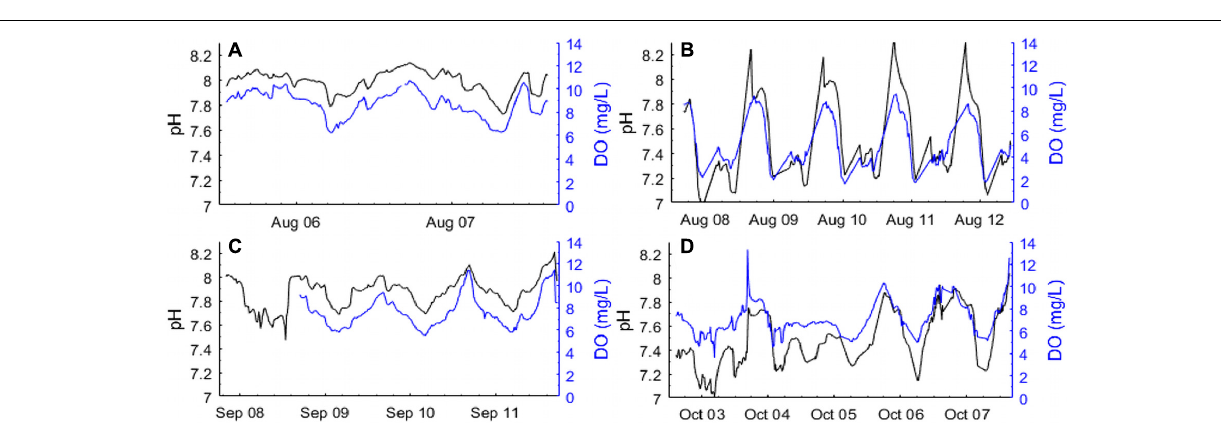
FIGURE 2 | High frequency diurnal measurements of pH T (Black lines; total H + scale) and dissolved oxygen (Blue lines; DO mg L − 1 ) in (A) a seagrass bed (SG-1) in August, (B) a salt marsh (SM-1) in August, (C) a seagrass bed (SG-1) in September, and (D) a salt marsh (SM-2) in October of